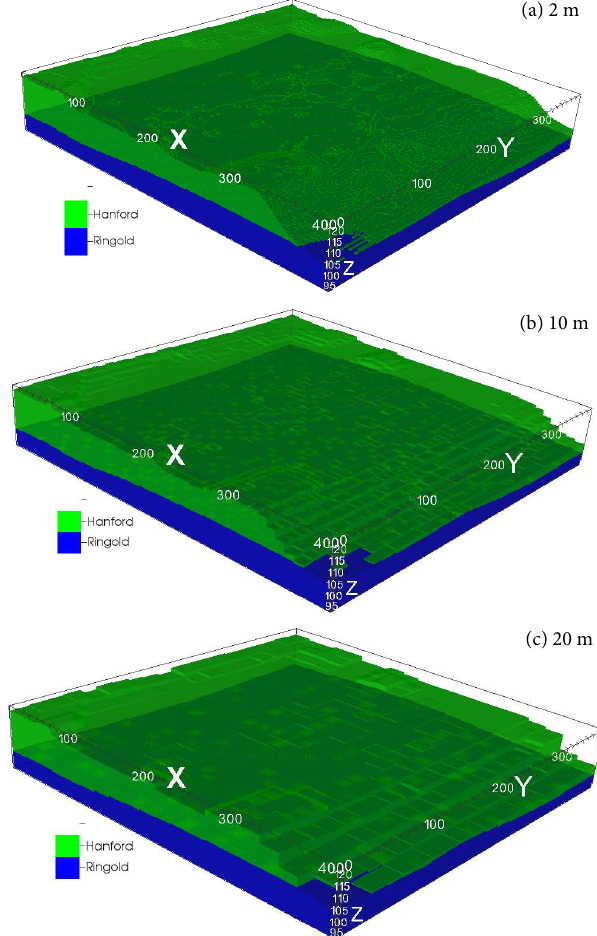
Figure 4. PFLOTRAN meshes and associated material IDs at (a) 2m, (b) 10m, and (c) 20m resolutions.